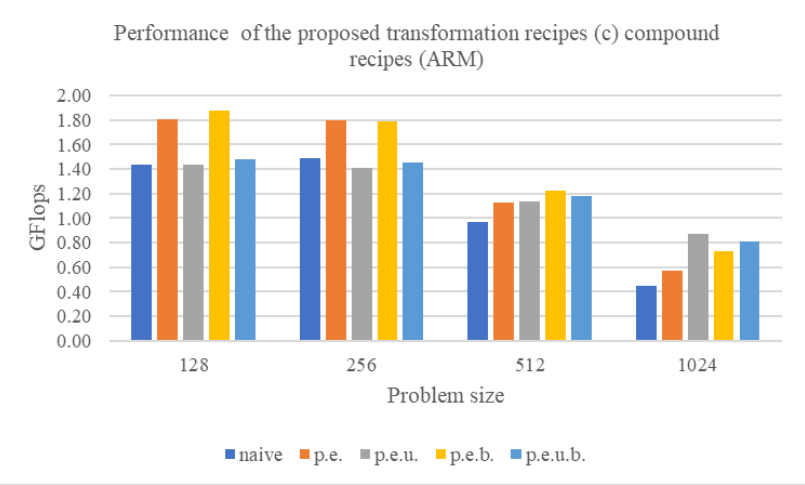
Figure 7. Experimental results of the proposed transformation recipes (c) compound recipes